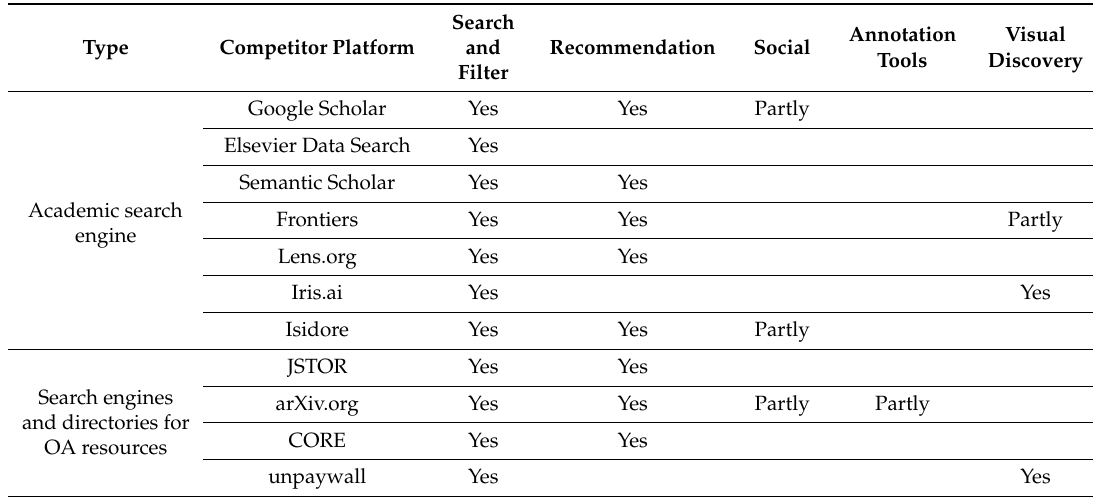
Table 3. TRIPLE’s main features compared to